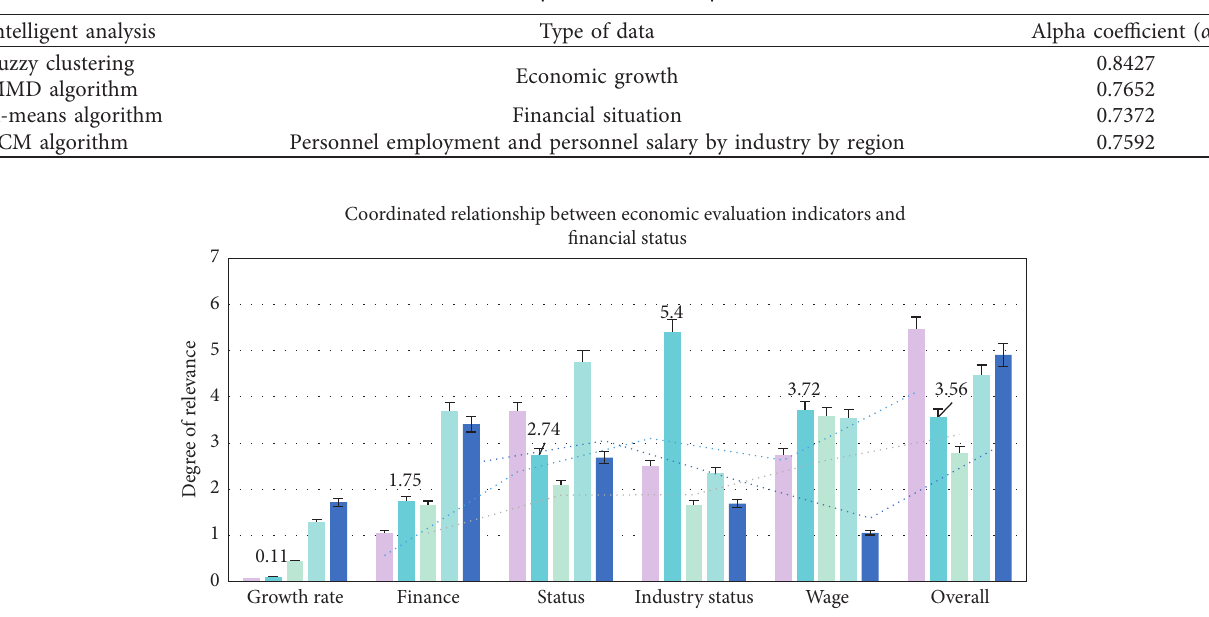
Table 1: Summary table of reliability test results.